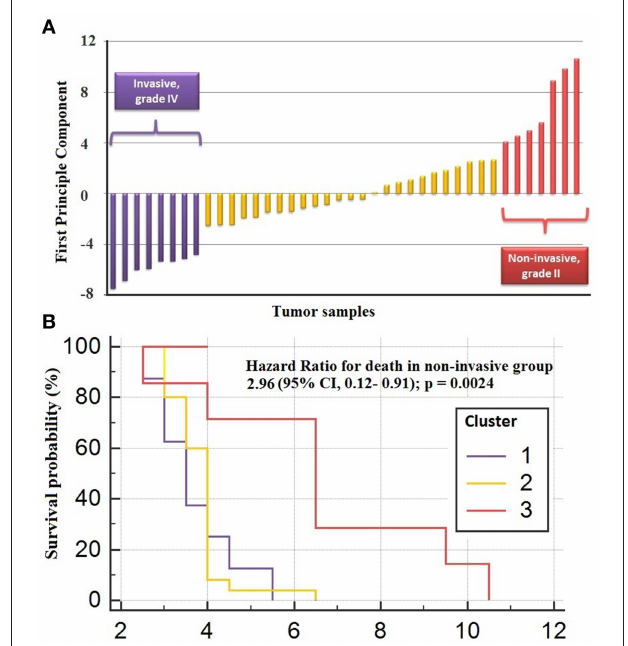
FIGURE 6 | Clustering of sub-types of NFPA with PCA analysis. (A) The clustering of samples via first principle component of expression profiles of core module genes (B) survival analysis by Cox regression model and Kaplan-Meier estimates indicated the predictive power of patient survival among the